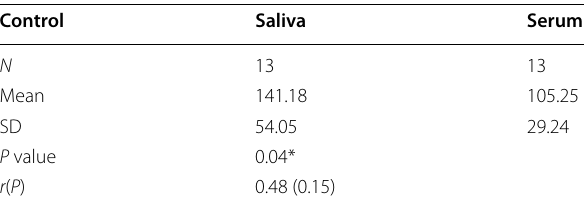
Table 2 Mean and standard deviation of saliva and serum in control group